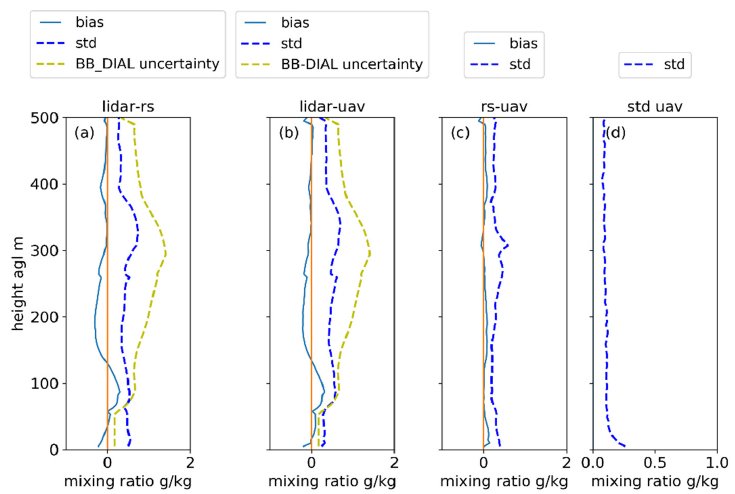
Figure 10. comparison (bias solid line, standard deviation and BB-DIAL uncertainty (dash line), ( a ) BB-DIAL-radiosonde, ( b ) BB-DIAL-UAV, ( c ) radiosonde-UAV. ( d ) is averaged standard deviation computed from each UAV sample (i.e., within a 4.8 m bins).